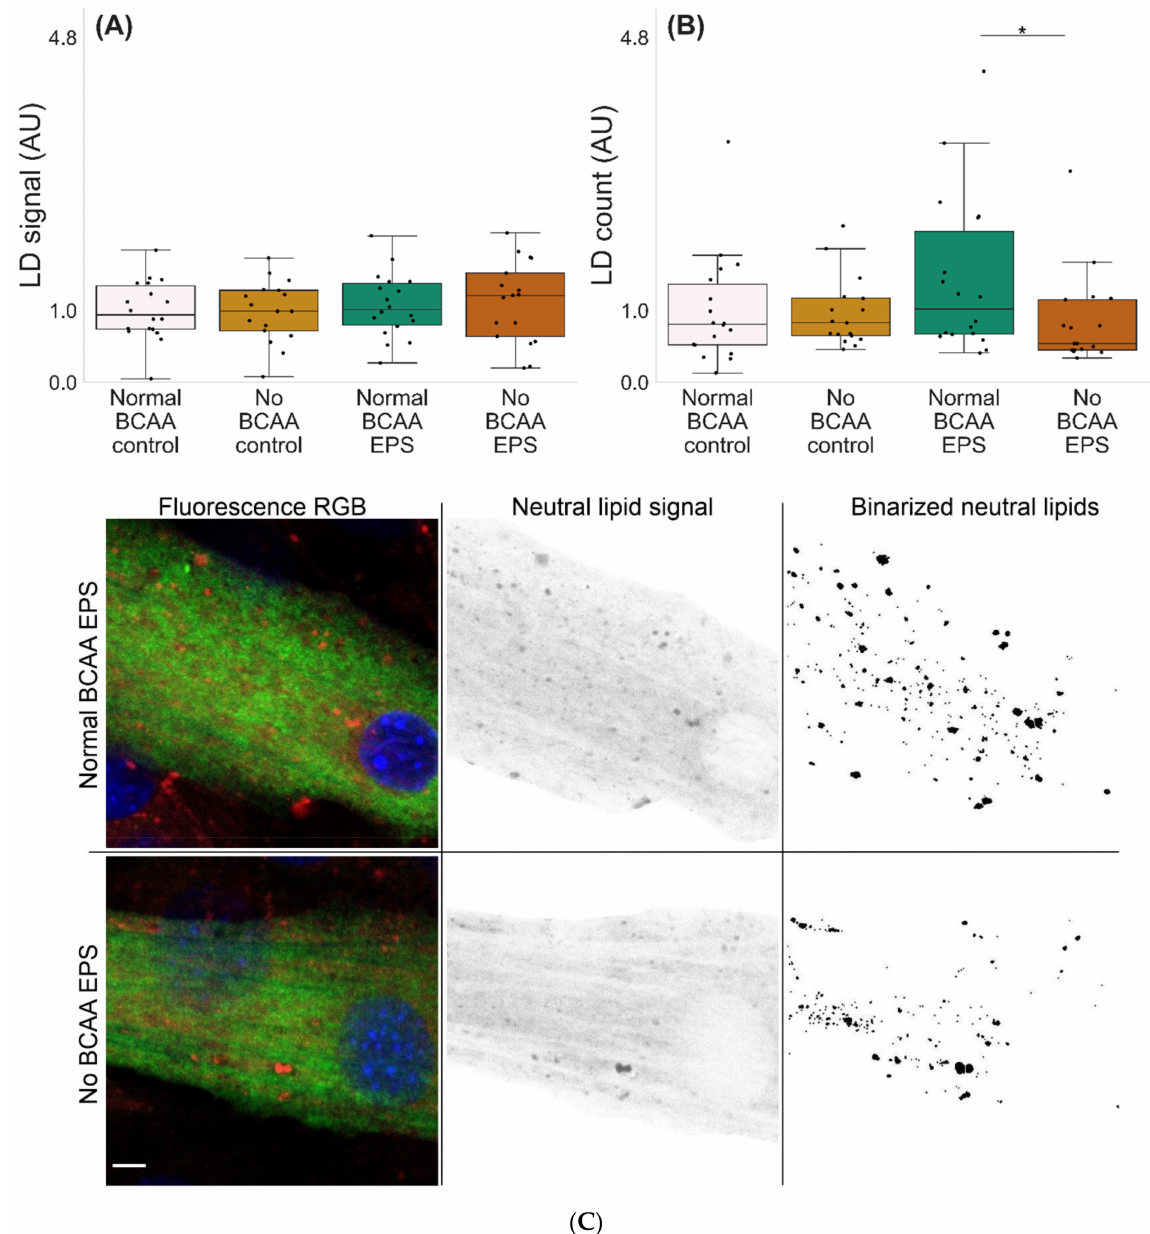
Figure 5. Lipid droplet characteristics in murine C2C12 myotubes ( A – C ). ( A ) In EPS-treated myotubes, there were no changes in LD signal fraction, whereas ( B , C ) BCAA deprivation diminished the number of LDs (EPS-treated myotubes 0.8 mmol BCAA vs. 0 mmol/L BCAA). n = 17–18/group. Boxes in the boxplot figures depict interquartile ranges and medians, and whiskers represent the 95% confidence interval, * p ≤ 0.050. BCAA = branched-chain amino acid, EPS = skeletal-muscle-specific exercise-like electrical pulse stimulation. In ( C ), MF20 = green, DAPI = blue and LD540 = red, gray and binary. Scale bar = 5 µ